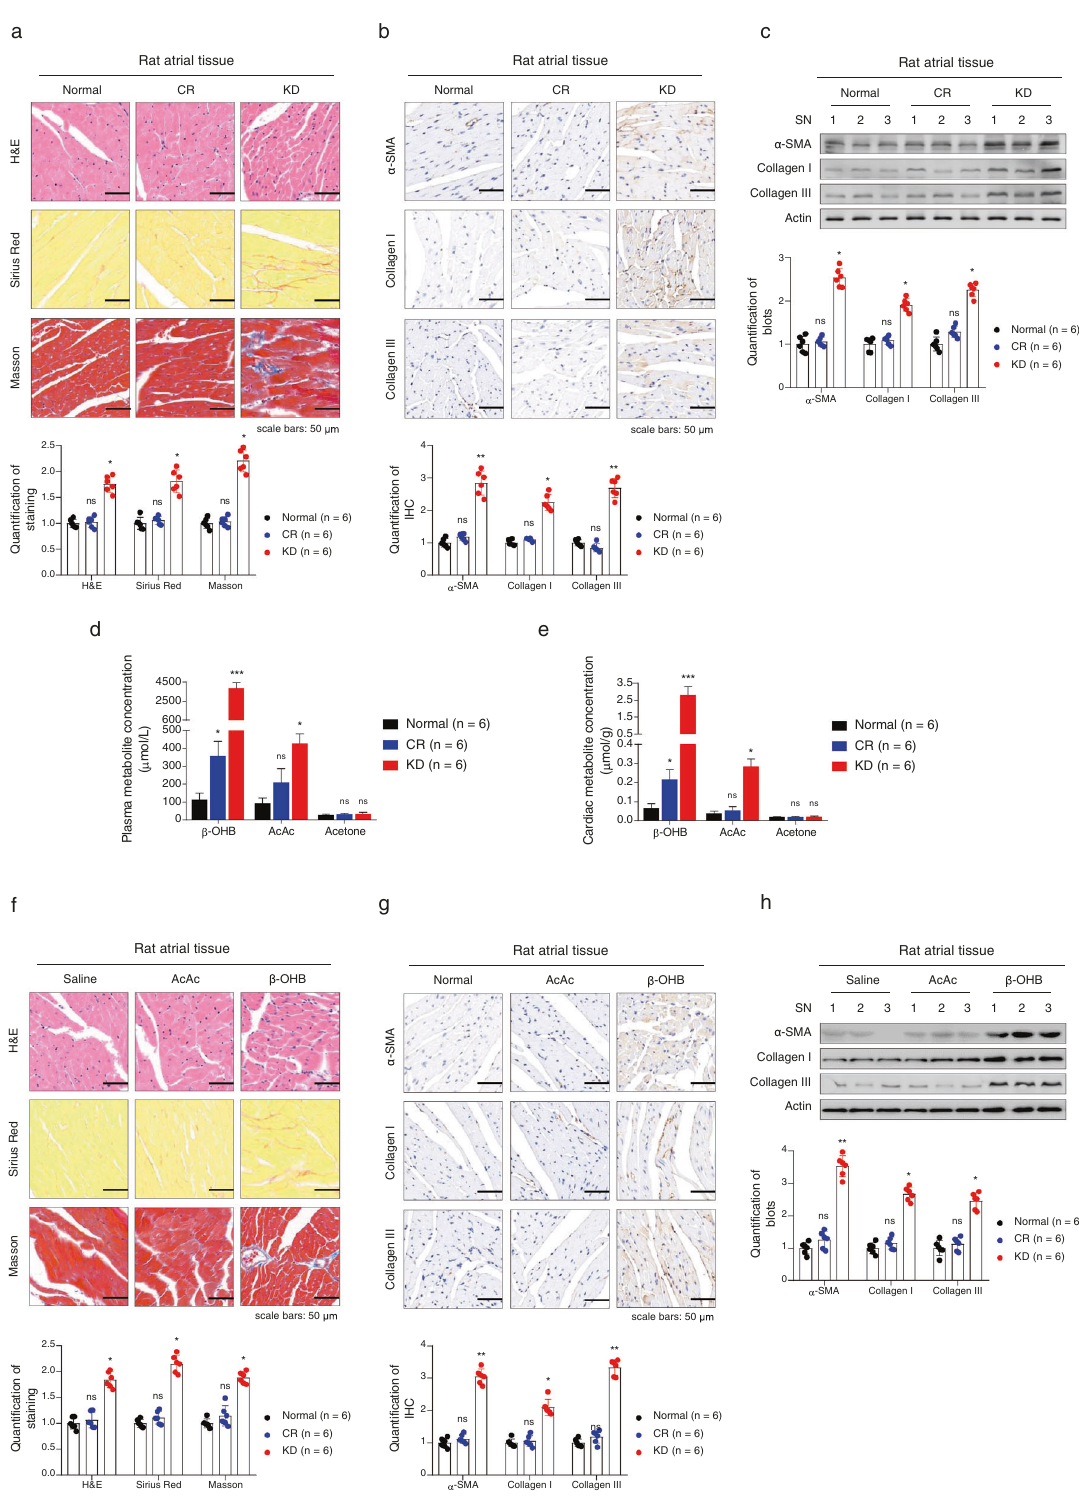
metabolic fl ux in cultured cell lines and primary cardiomyocytes. Decreased levels of citrate cycle metabolites and increased levels of the glycolytic metabolites pyruvate and lactate were observed in β -OHB-treated cells (Fig. 2h). Together with our results showing that decreased levels of citrate cycle metabolites and